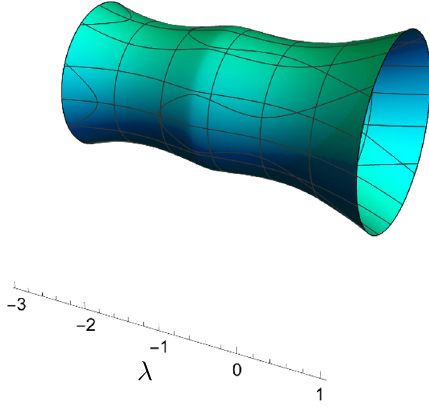
Figure 8 . The Python’s Lunch wormhole constructed from the AdS plus dust metric depicted in (cid:12)gure 7. Here as well, (cid:21) is the a(cid:14)ne parameter along the boundary geodesics (cid:13) 1 ; 2 . ometries, allowing for an arbitrary (cid:26) ( x; z ), provides a multitude of fruitful future